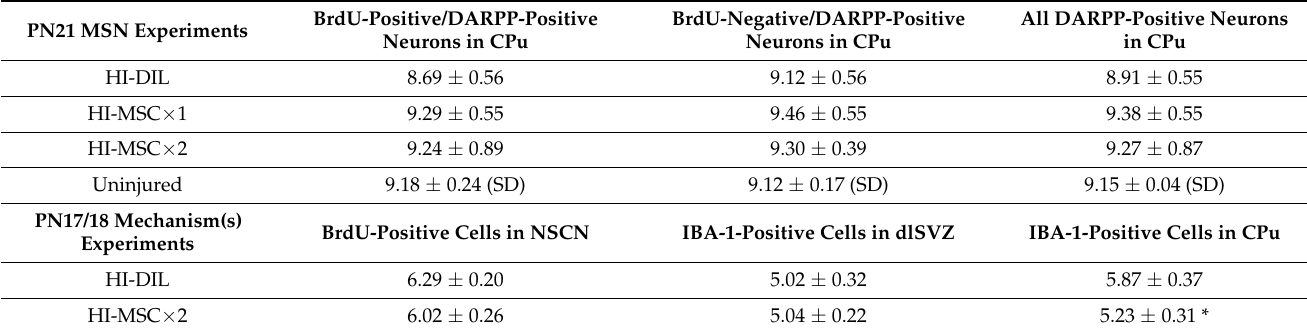
Table 3. Average ( ± SEM, or SD when indicated) of the nuclear or somal diameter for each